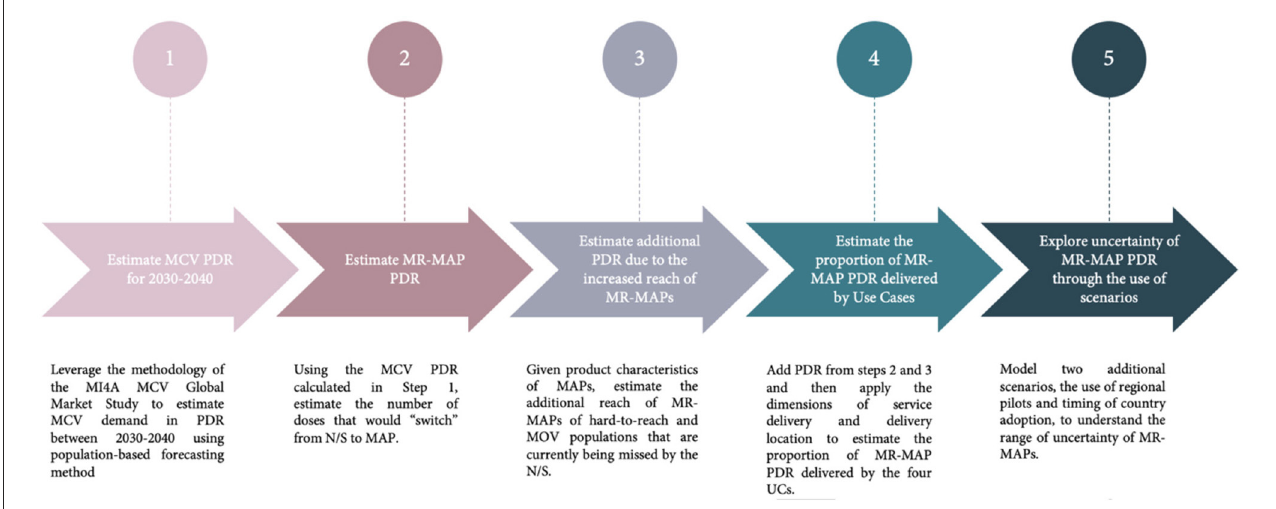
FIGURE3 Estimated MR PDR delivered by MAPs and N/S for countries using MR in their national immunization schedules, between 2030 and 2040. MR, measles rubella; PDR, programmatic doses required; MAPs, microarray patches; and N/S, needle and syringe.